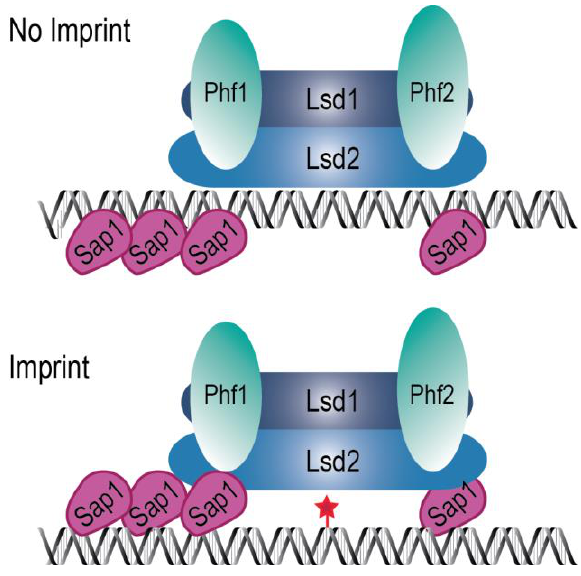
FIGURE 10: The imprintosome. Schematic view of the model of binding of Lsd1/2 and Sap1 at mat1 . Lsd1/2 complex is repre- sented in blue with Phf1/2 in green. Sap1 is represented in pink. The imprint is represented by a red star. Upper panel, Lsd1/2 complex is recruited on the imprint site on the chromatid with no imprint independently of Sap1. Lower panel, when the imprint is formed Sap1 stabilizes the Lsd1/2